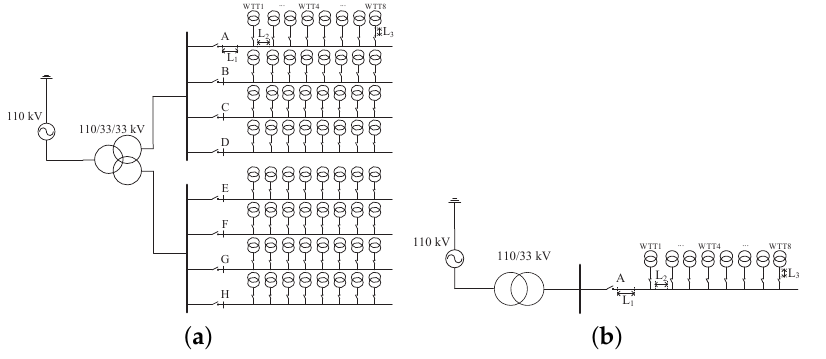
Figure 1. Layout of an offshore wind farm (OWF): ( a ) a typical OWF; and ( b ) simplified layout. WTT: wind turbine